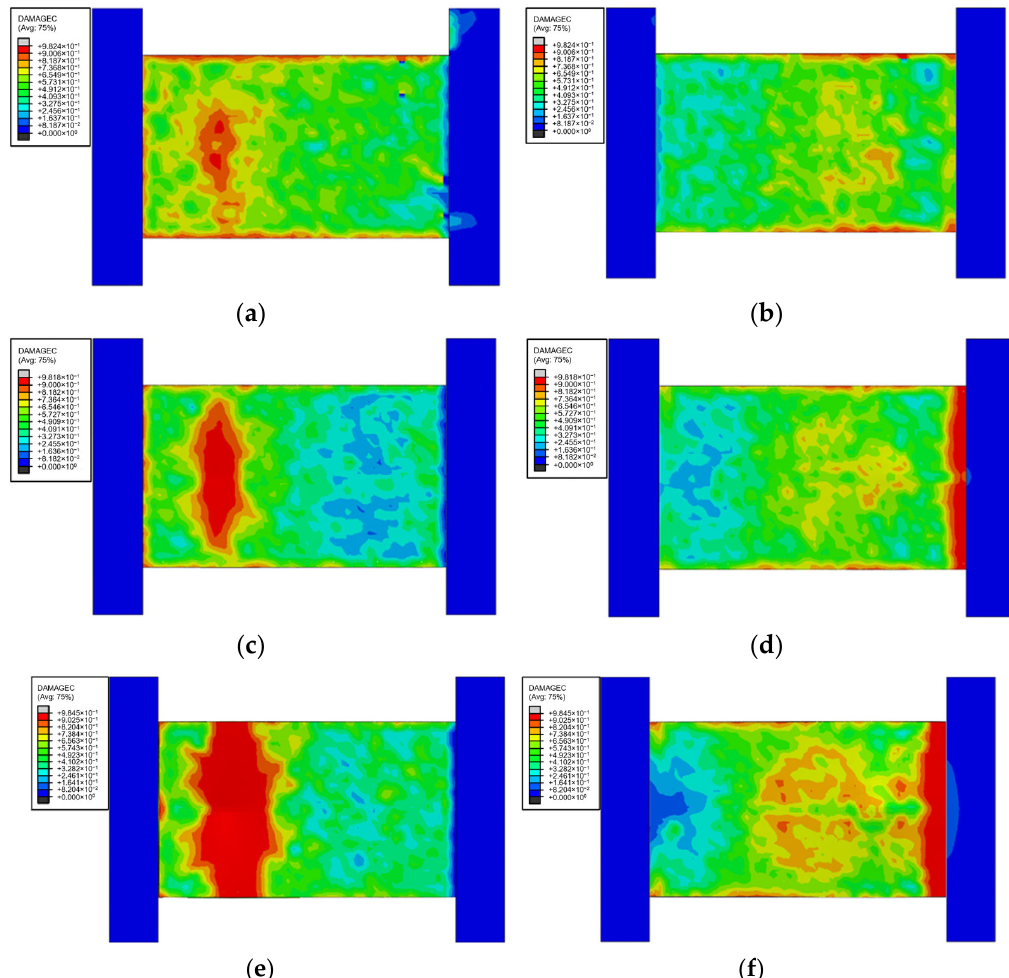
Figure 19. Failure characteristics of the prefabricated shear walls with 10% grouting defects under different explosive equivalent values. ( a ) 3 kg, front blasting surface. ( b ) 3 kg, back blasting surface. ( c ) 5 kg, front blasting surface. ( d ) 5 kg, back blasting surface. ( e ) 9 kg, front blasting surface. ( f ) 9 kg, back blasting surface.